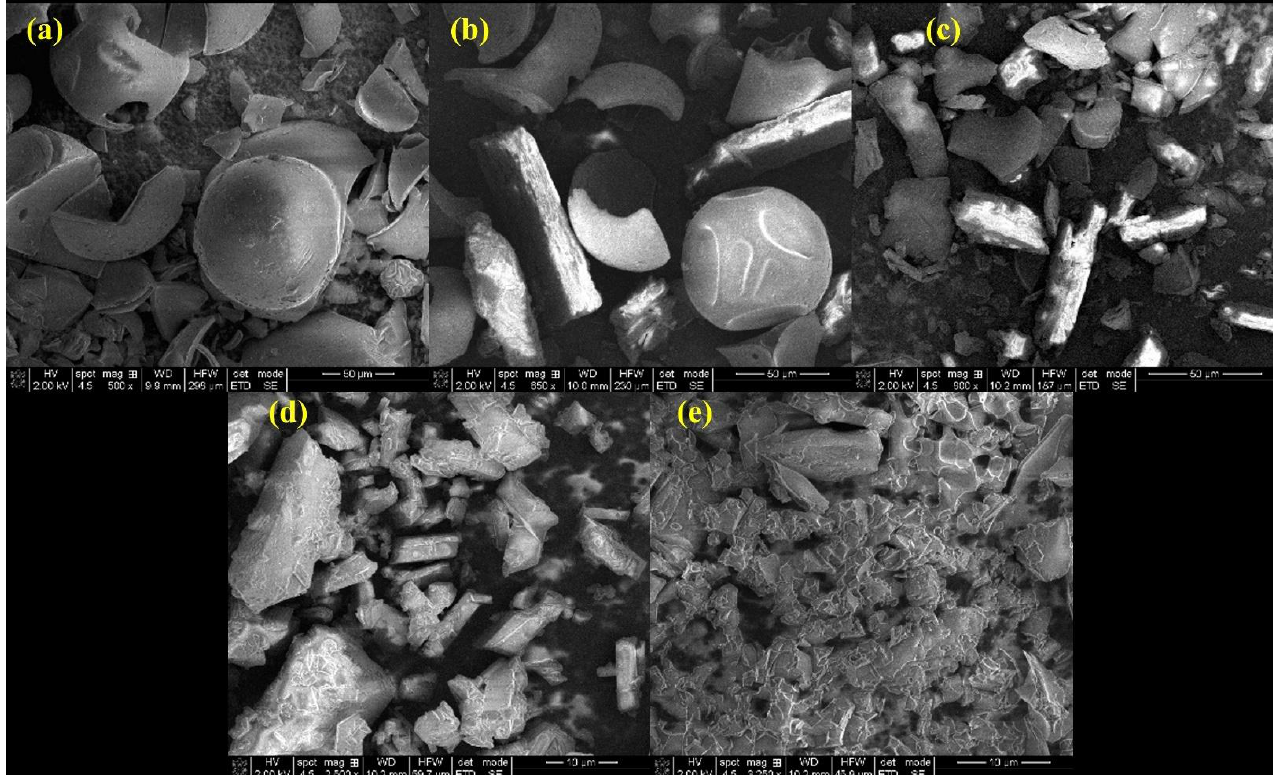
Figure 4. SEM images of ( a ) Me- β -CD, ( b ) AML-Me- β -CD physical mixture, ( c ) AML-Me- β -CD kneading method, ( d ) AML-Me- β -CD coprecipitation method, and ( e ) AML-Me- β -CD lyophiliza- tion method.